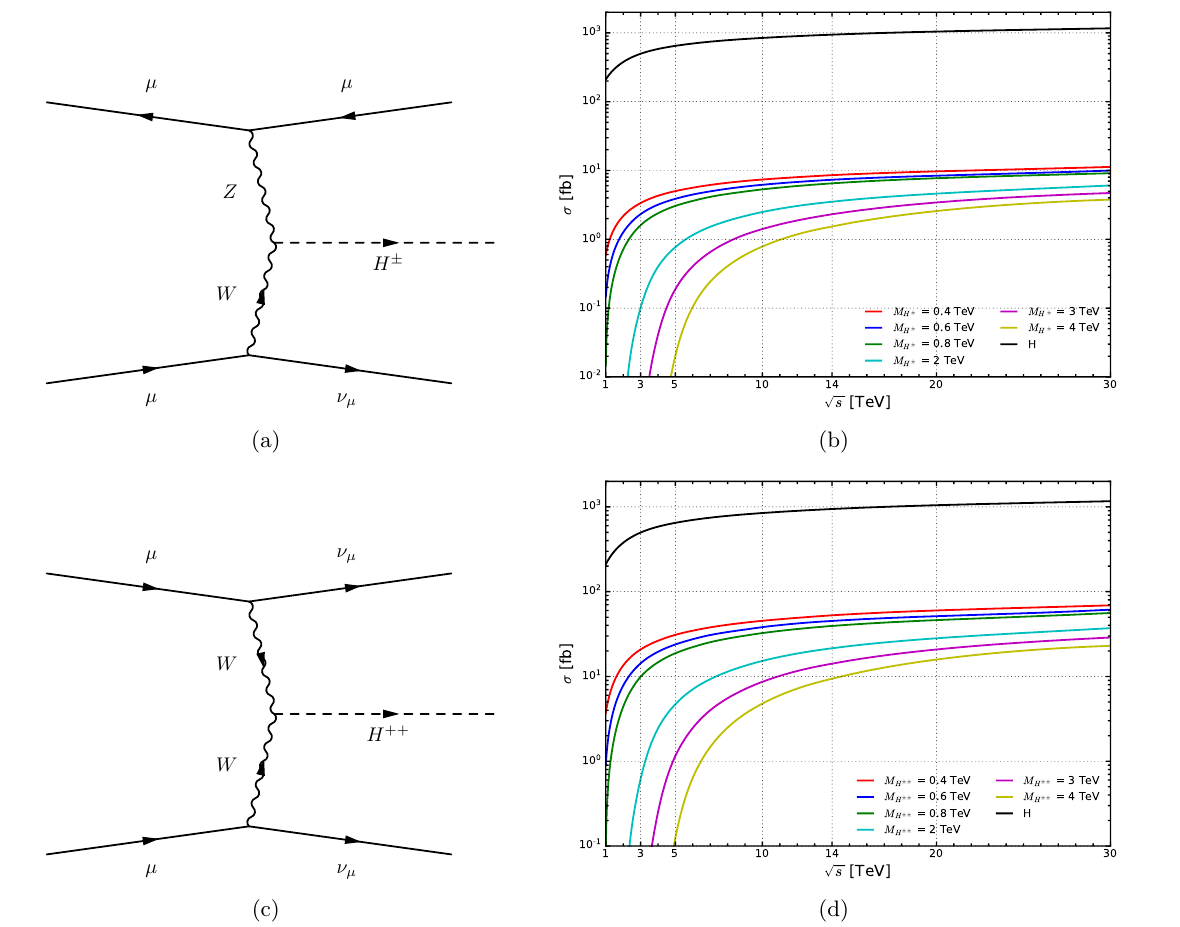
Figure 11 . (a) Diagrammatic representation of H (cid:6) through EW VBF in the GM model, in (cid:22) + (cid:22) (cid:0) collisions. (b) The H (cid:6) production rate [fb] via EW VBF in (cid:22) + (cid:22) (cid:0) collisions as a function of collider p energy s [TeV] for representative M . (c,d) Same as (a,b) but for H ++ in (cid:22) + (cid:22) + collisions. H (cid:6)